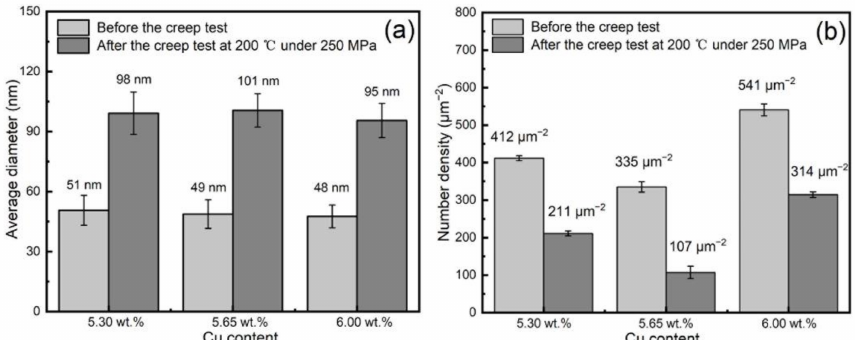
Figure 3. Statistical results of ( a ) average diameter and ( b ) number density of the Ω phase evolution of three Al–Cu–Mg–Ag alloys before and after the creep test at 200 ◦ C under 250